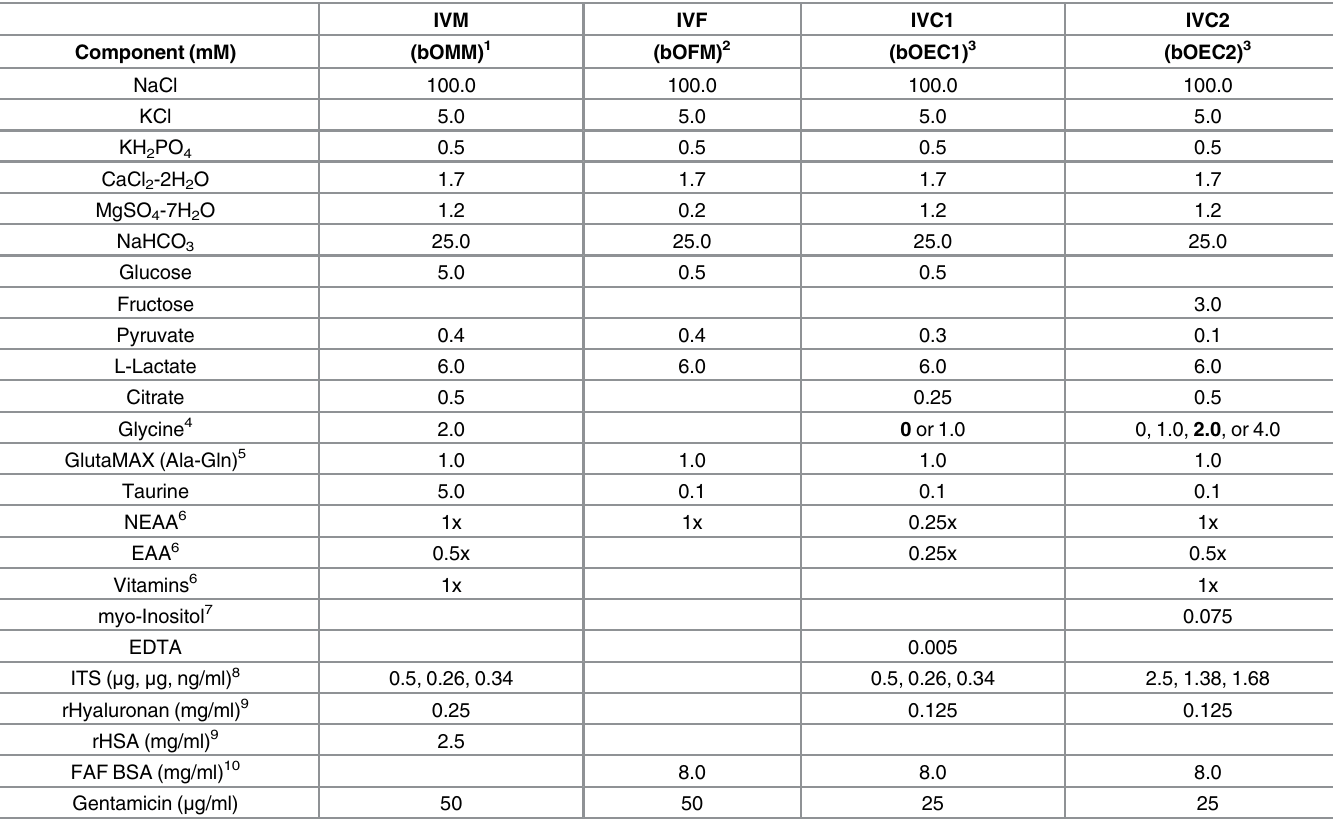
Table 1. Composition of Culture